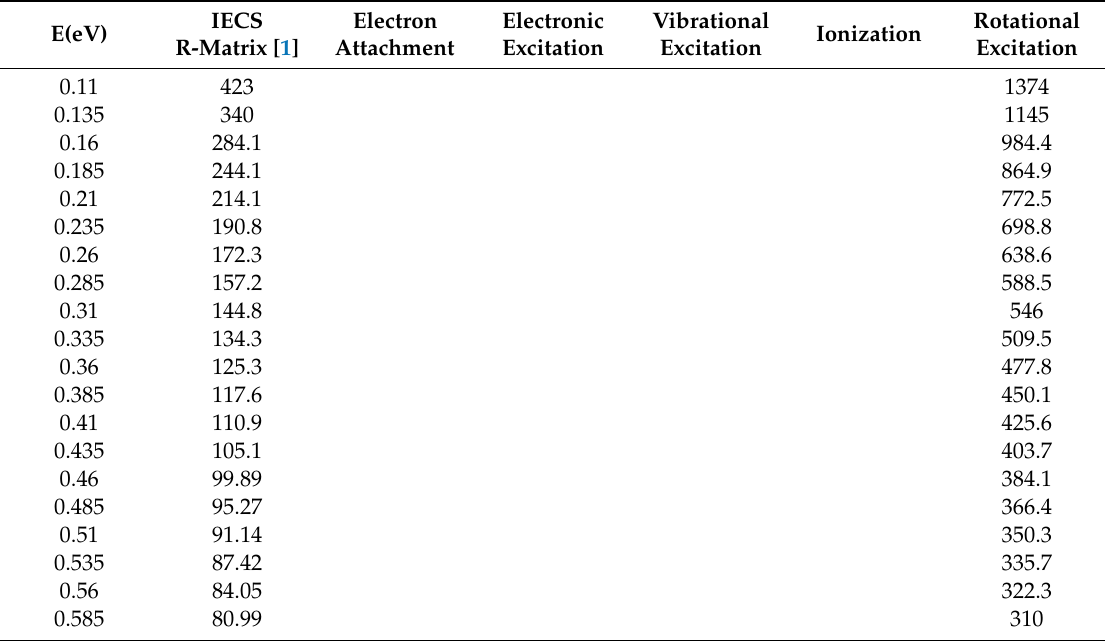
Table 1. Complete set of integral electron scattering cross sections for pyridine, in the energy